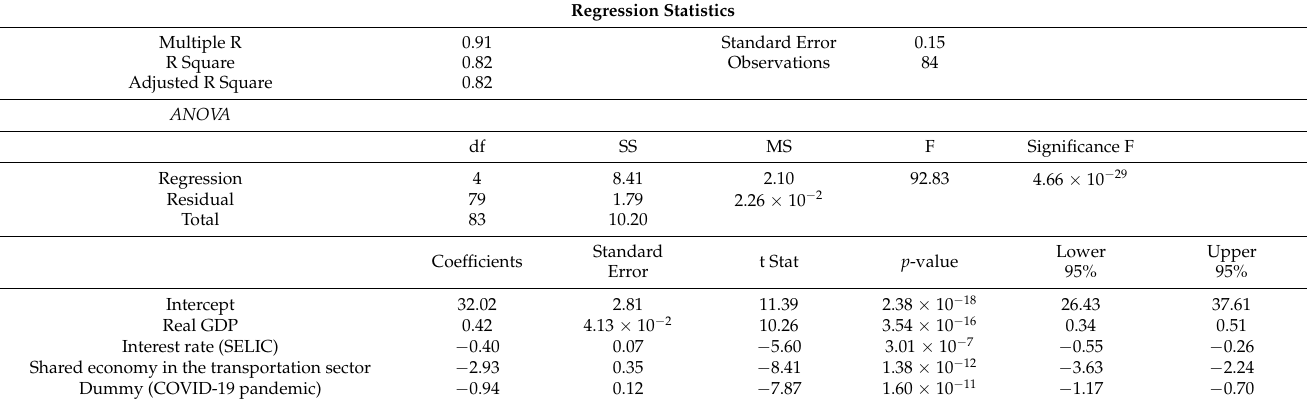
Table A1. Regression statistics, ANOVA table, and coefficient statistics for the proposed model considering shared economy in the transportation